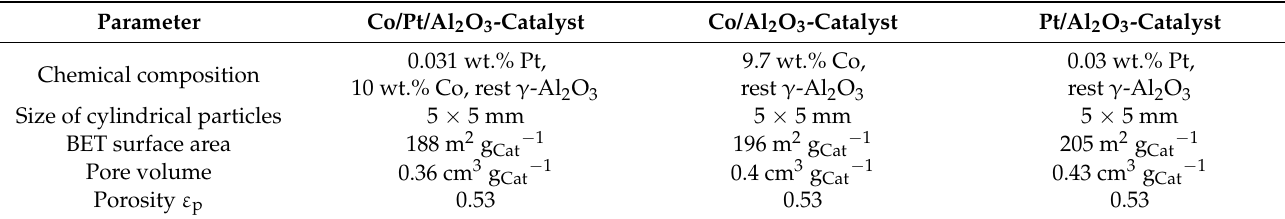
Table 3. Characteristics of the synthesized catalysts used in this